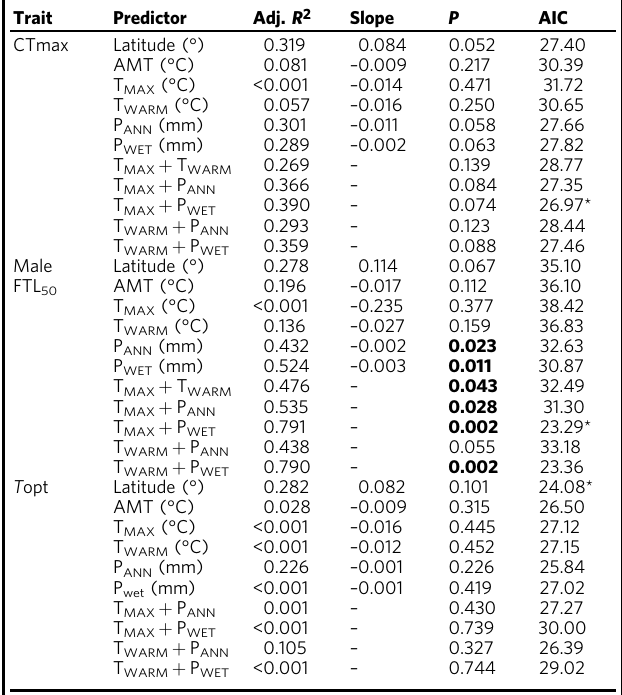
Climatic predictors included latitude (commonly used as a proxyfor temperature), annual mean temperature (AMT), maximum temperature of the warmest month (T MAX ), mean temperature of the warmest quarter (T WARM ), annual precipitation (P ANN ) and precipitation of the wettest quarter (P WET ). The association between these traits and the predictor variables T MAX , T WARM, P ANN and P WET were also compared using a multiple regression approach. Signi fi cant P values are highlighted in bold, while the model with the best Akaike Information Criterion (AIC) is highlighted with an asterisk. Source data are provided as a Source Data fi